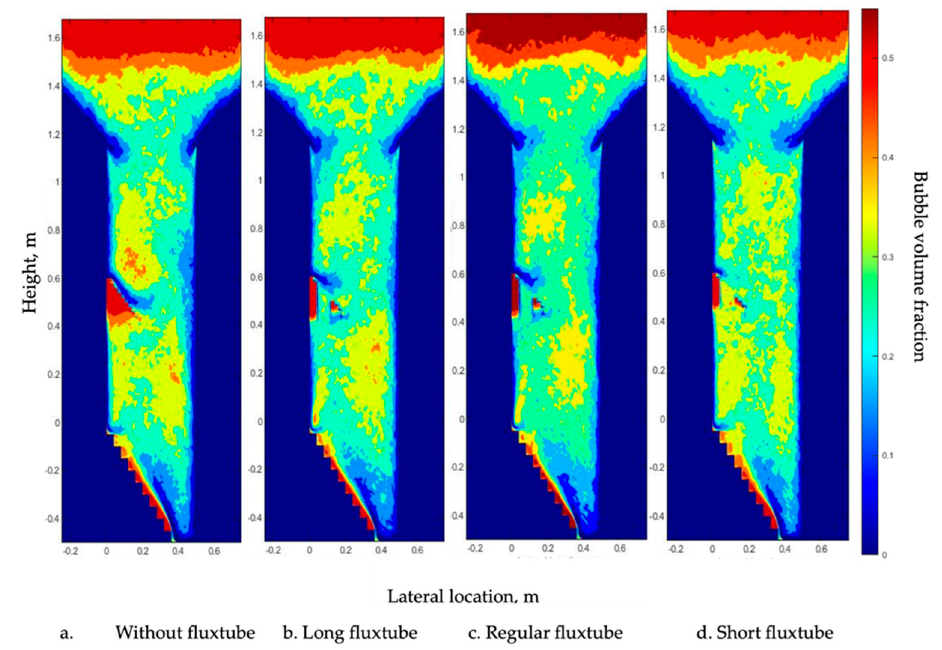
Figure 14. Bubble volume fraction contours in the entire fluidized bed reactor using the asymmetrical baffle without a fluxtube and with fluxtubes baffle of different lengths under the superficial gas velocity of 0.4 m/s for the even gas inlet configuration.